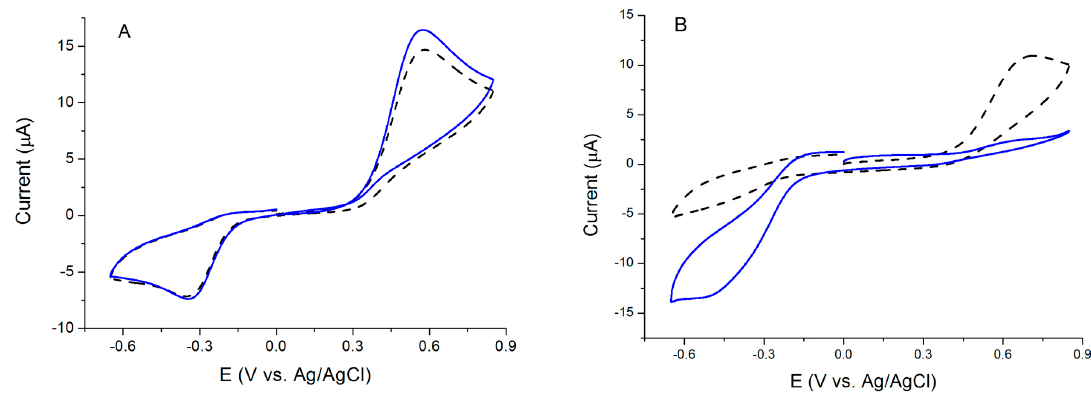
Figure 1. Cyclic voltammograms recorded at 50 mV s − 1 in 1 mM H 2 Q, 0.05 M PBS (pH 7.4) ( A ) with a bare nanoelectrode ensemble (NEE) before (dashed line) and after (solid line) the addition of 1.5 mM H 2 O 2 ; and ( B ) with a NEE functionalized with transglutaminase incubated with anti-tTG and then with secAb-HRP (i.e., TGNEE–antiTG–secAb-HRP), before (dashed line) and after (solid line) the addition of 1.5 mM H 2 O 2.